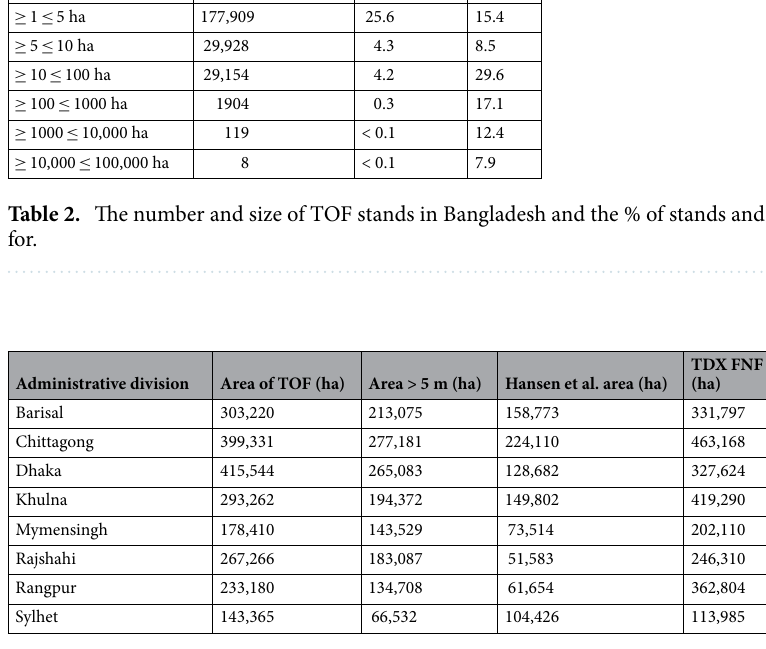
Table 3. Area of TOF mapped compared with that of a canopy height greater than 5 m and in comparison with the extent-equivalent modified Hansen 32 dataset and DLR FNF map 33 .